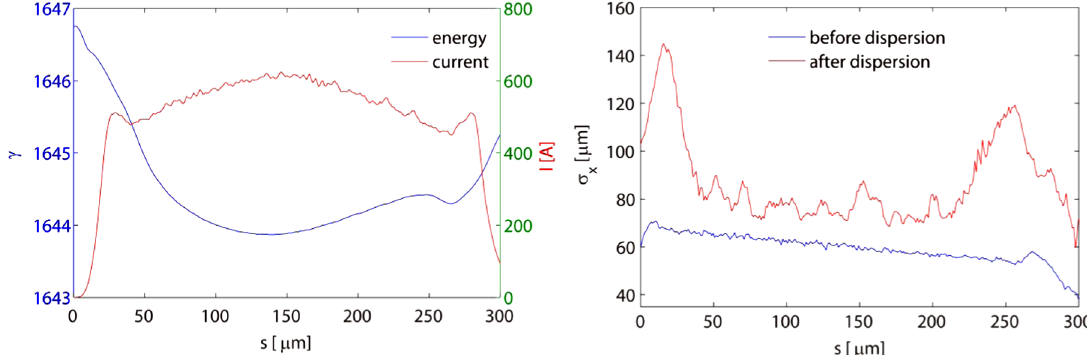
FIG. 4. Simulated parameters at the exit of the linac. (a) Beam energy and current distribution along the electron beam. (b) Horizontal beam size before and after the dispersion.